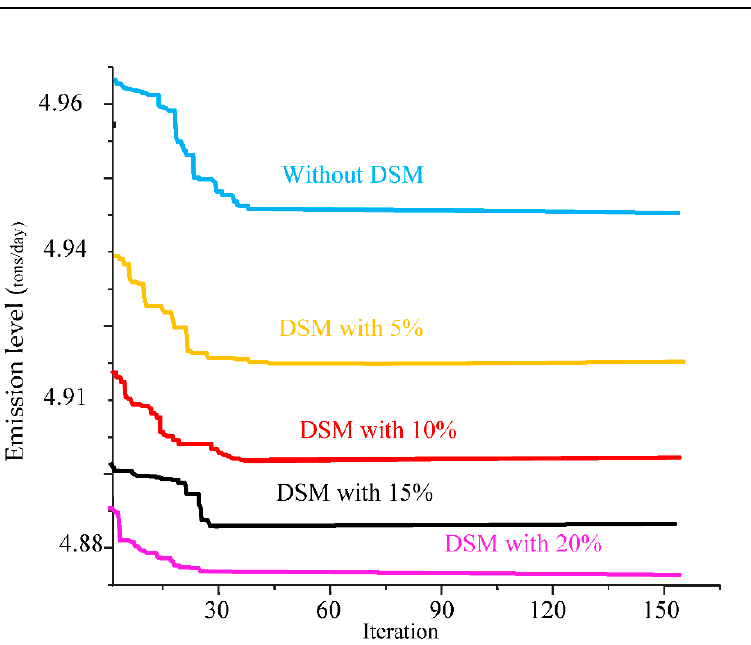
Figure 8. The convergence features of dynamic emission dispatch by different levels of DSM participation. Table 3. Dynamic emission distribution by various levels of DSM participation.